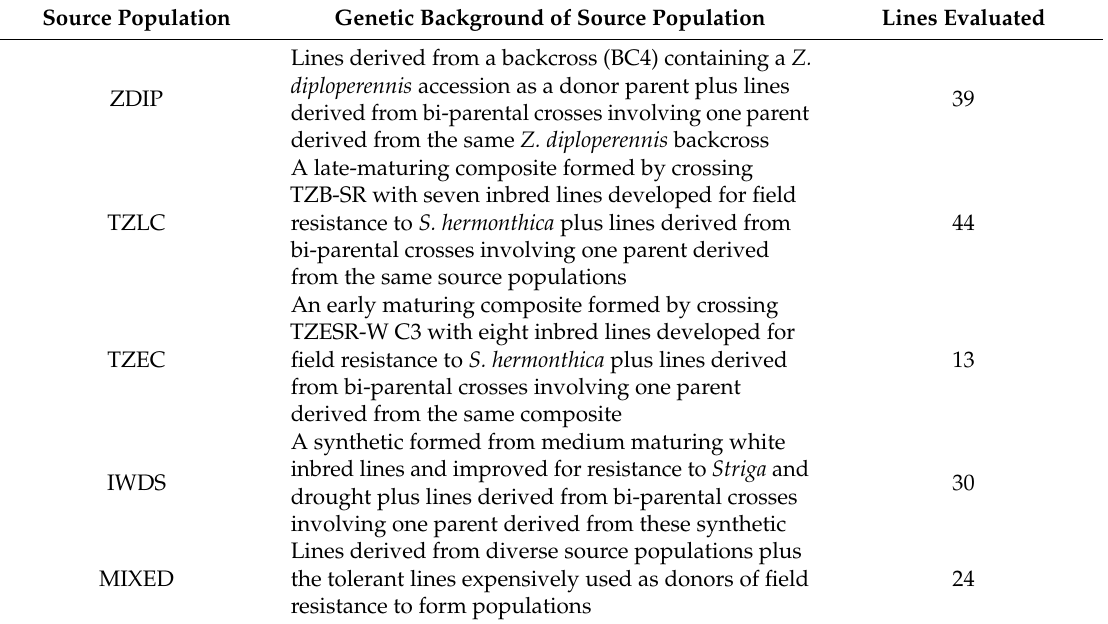
Table 1. List of source populations for the 150 inbred lines used in this